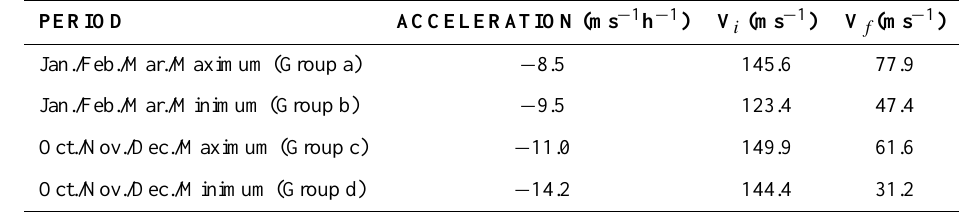
Table 2. Accelerations and velocities at 20:00 LT and 04:00 LT obtained from Fig. 1. PERIOD